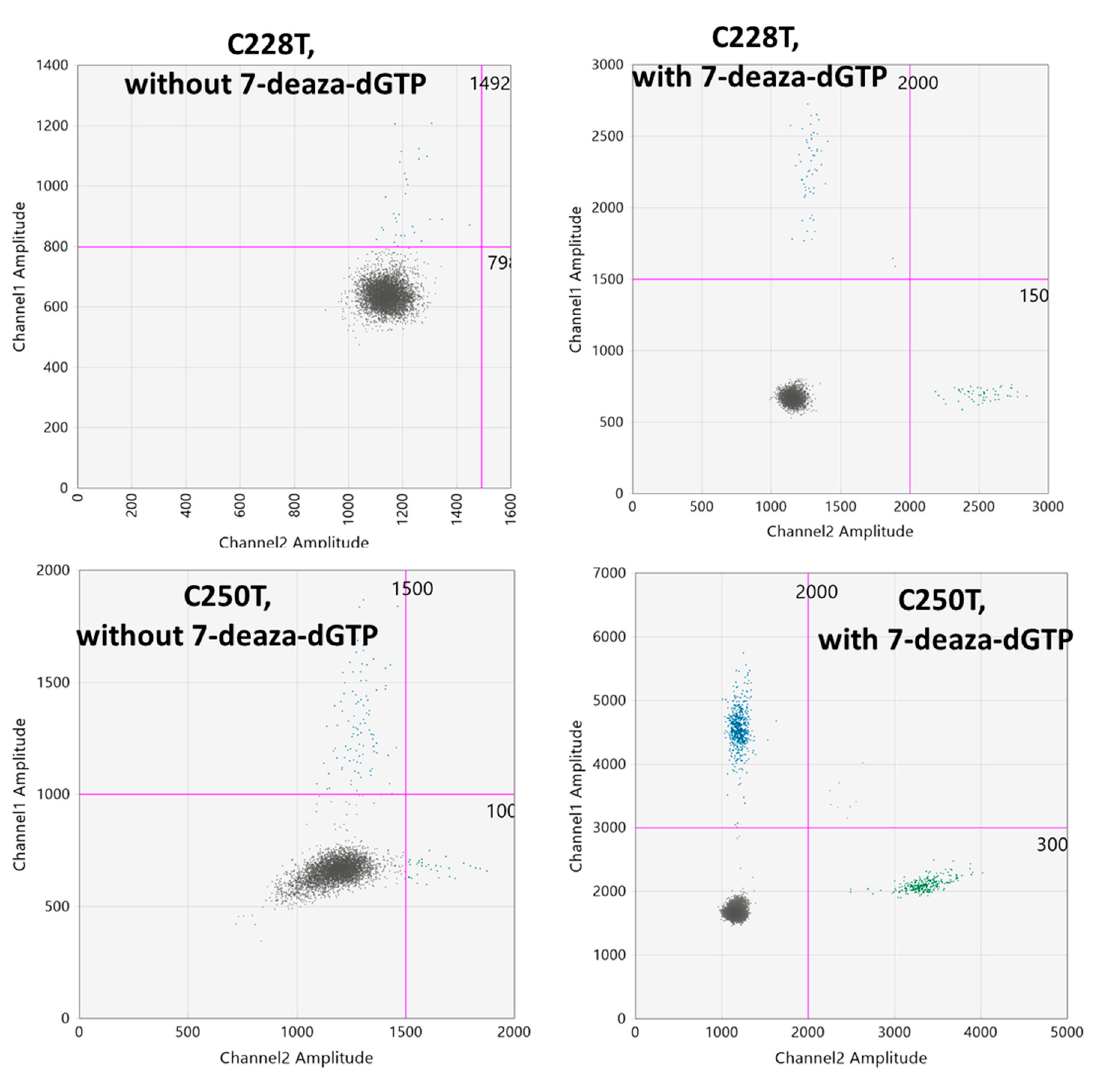
Figure 1. Effect of the 7-deaza-dGTP reagent (2 µM) in generating clear droplet clusters for C228T and Figure 1. E ff ect of the 7-deaza-dGTP reagent (2 µ M) in generating clear droplet clusters for C228T and C250T assays. C250T